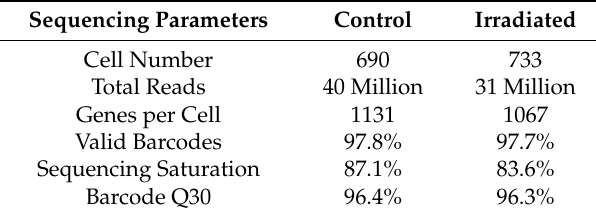
Table 1. Quality of the single cell RNA-seq